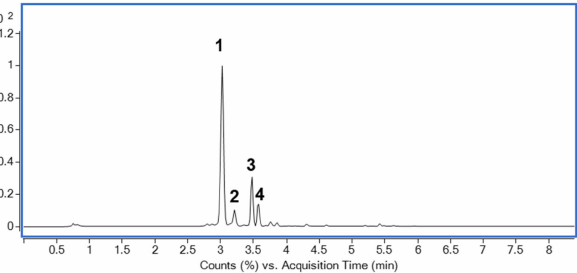
Figure 8. Base peak chromatogram of Daphne jejudoensis leaf extract (DJLE) using LC-QToF in negative ESI mode: daphnin ( 1 ), rutin ( 2 ), daphnetin ( 3 ), and cynaroside ( 4 ).